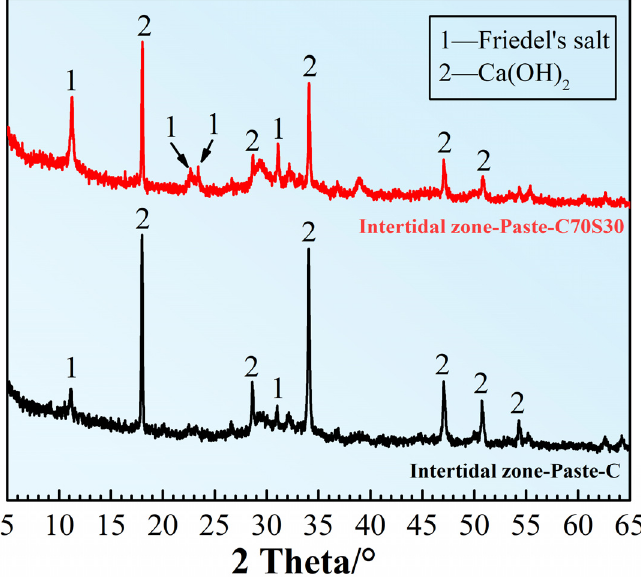
Figure 16. The influence of slag powder on the composition of CBRM-Paste after 180 days of dry–wet cycles-coupled chloride ion erosion.